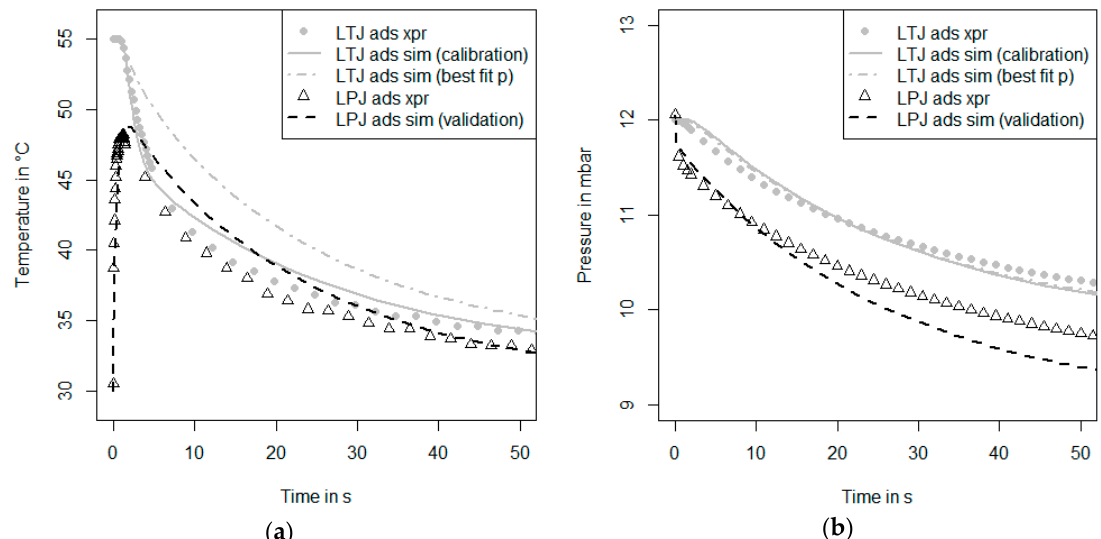
Figure 9. Surface temperature of sample 3_Fib measured in the experiments and simulated surface temperature for both calibration and validation measurement ( a ) and the corresponding pressure timelines in the dosing chamber ( b ). Additionally, the simulation values of the LTJ adsorption calibration measurement are shown for the case if only the pressure signal is fitted (indicated with ‘best fit p’ in the legends).